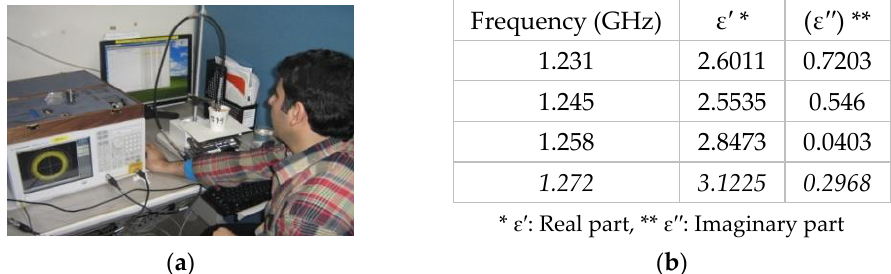
Figure 3. Dielectric constant measurement toolkit ( a ), and some soil sample results are shown in the right table of for samples in the field ( b ).